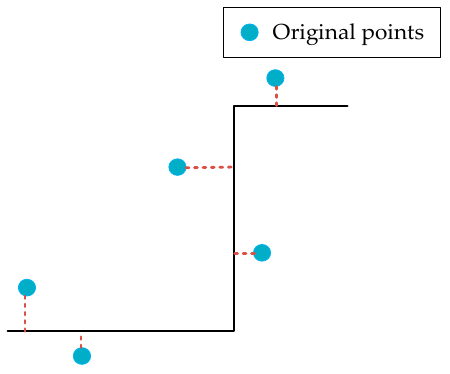
Figure 14. The distance computation of points. Red dotted lines denote the corresponding distances.